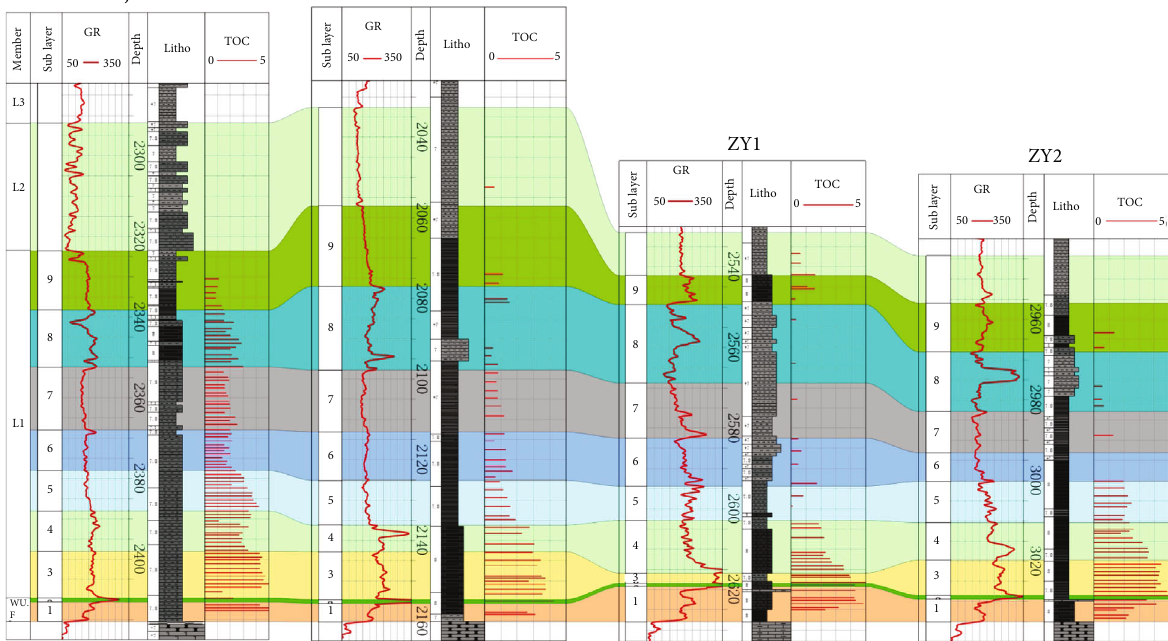
Figure 6: Comparison chart of TOC of Wufeng-Longmaxi Formation in southeast